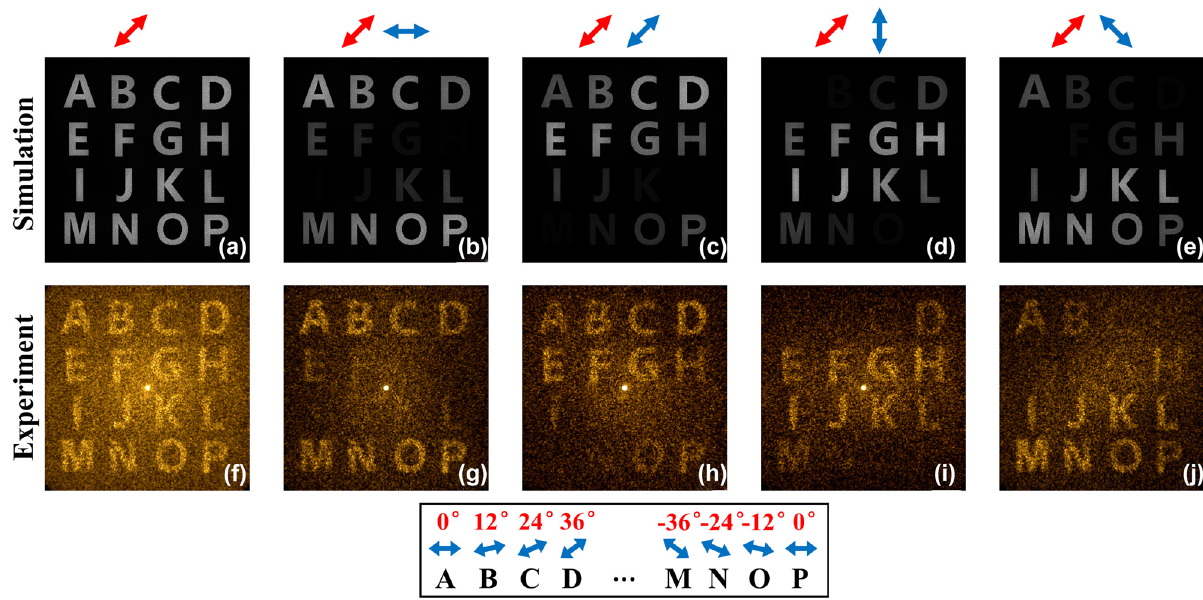
Figure 4: Simulated and experimental results of the reconstructed images. (a)–(j) Simulated and experimental results of the reconstructed holographic images in different diffraction orders that located at the Fourier plane. The red and blue arrows indicate the polarizations of incident and output light. The theoretical polarization states of the reconstructed images (from A to P) are represented in the bottom